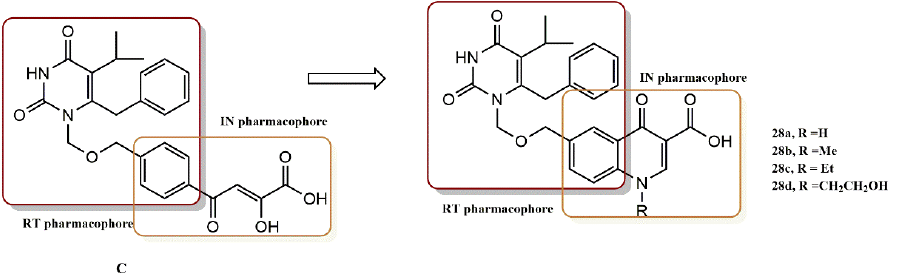
Figure 25. RT and IN pharmacophores of new active synthesized compounds 28a-d .